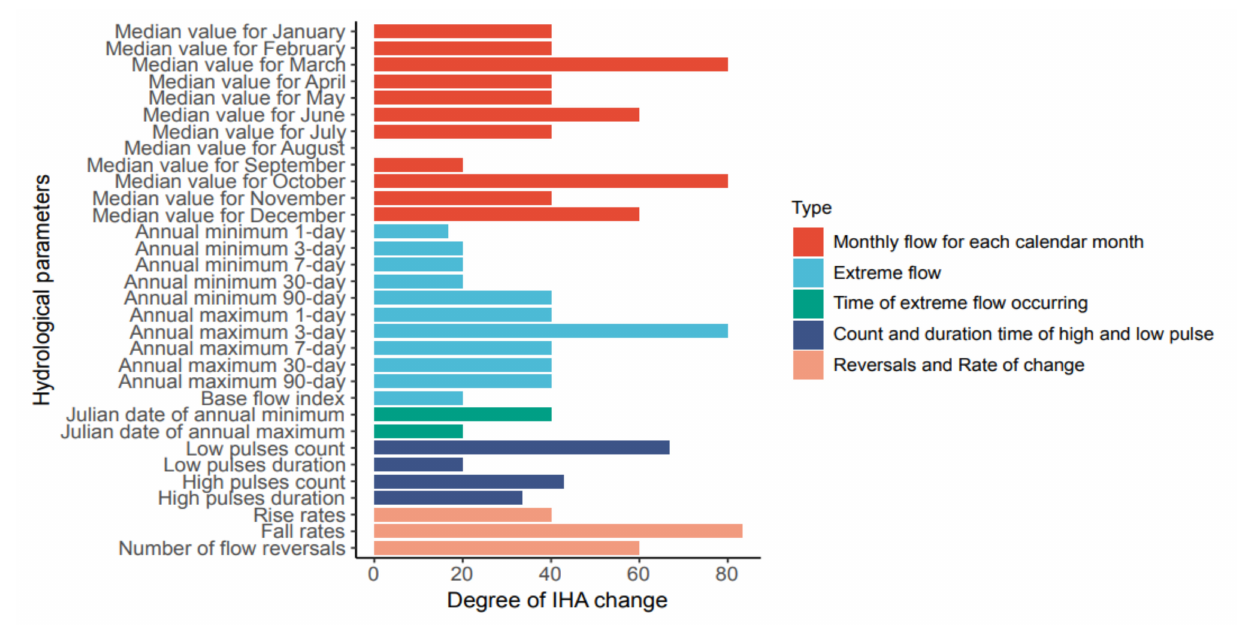
Figure 7. Degrees of Indicators of Hydrologic Alteration in the Wujiang River Basin. Table 4. Statistics of degrees of Indicators of Hydrologic Alteration of Wujiang River.